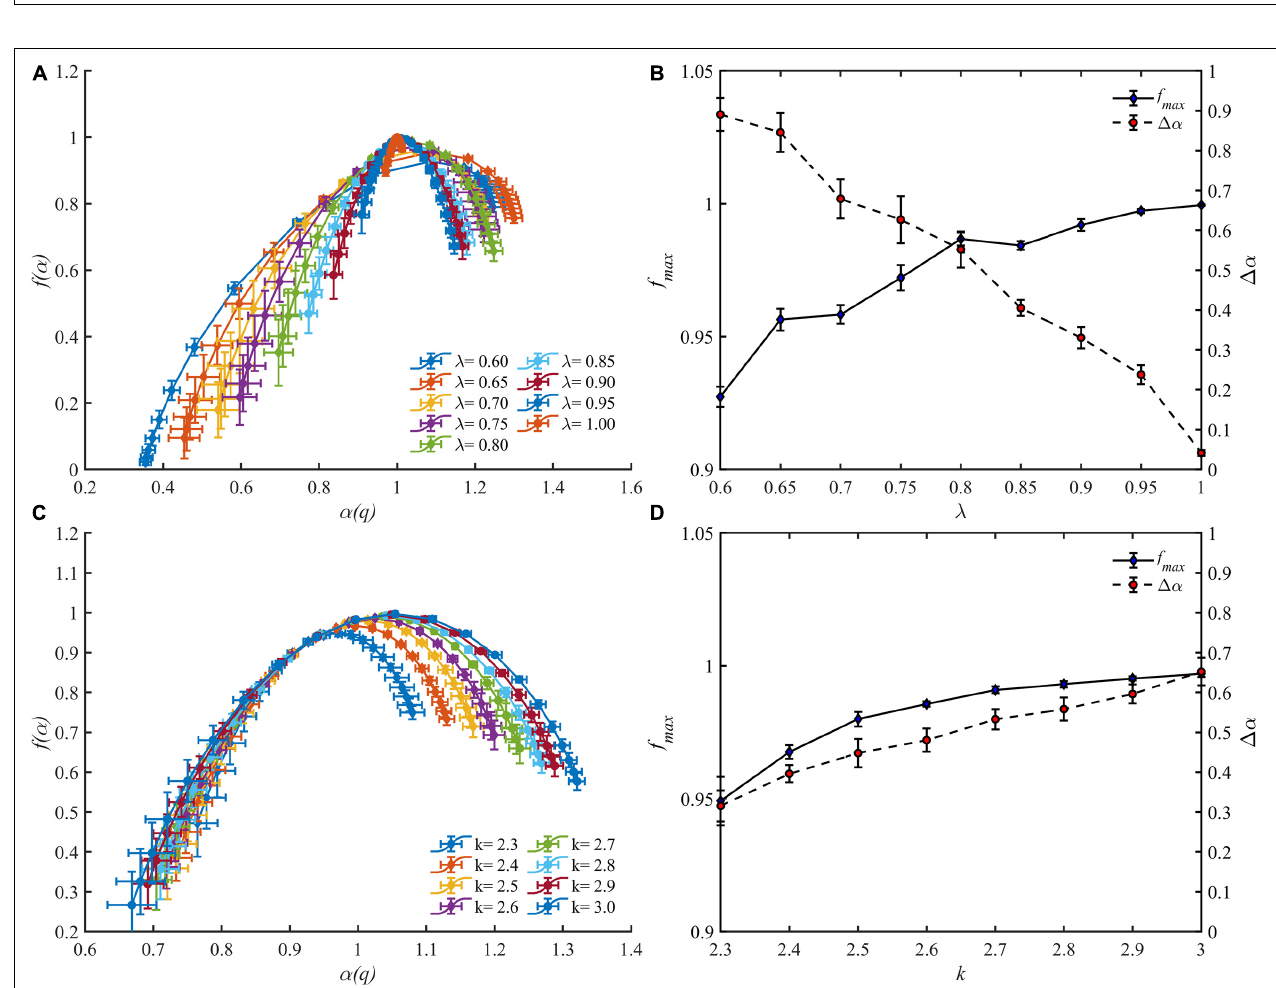
Frontiers in Physiology |